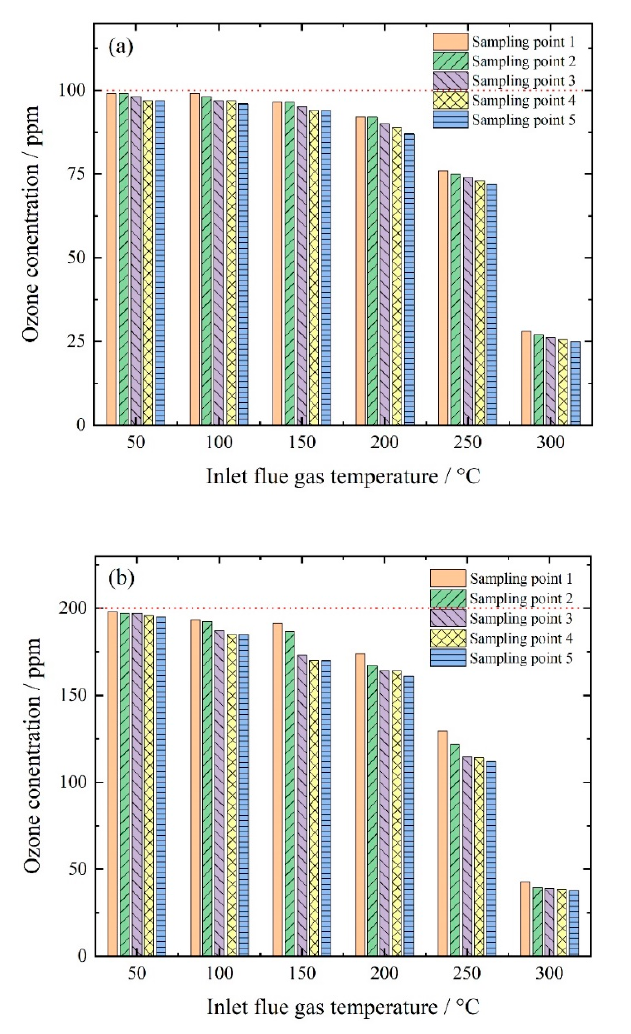
Figure 3. The change of ozone concentrations with flue gas temperatures at different inlet initial ozone concentration levels: ( a ) 100 and ( b ) 200 ppm.